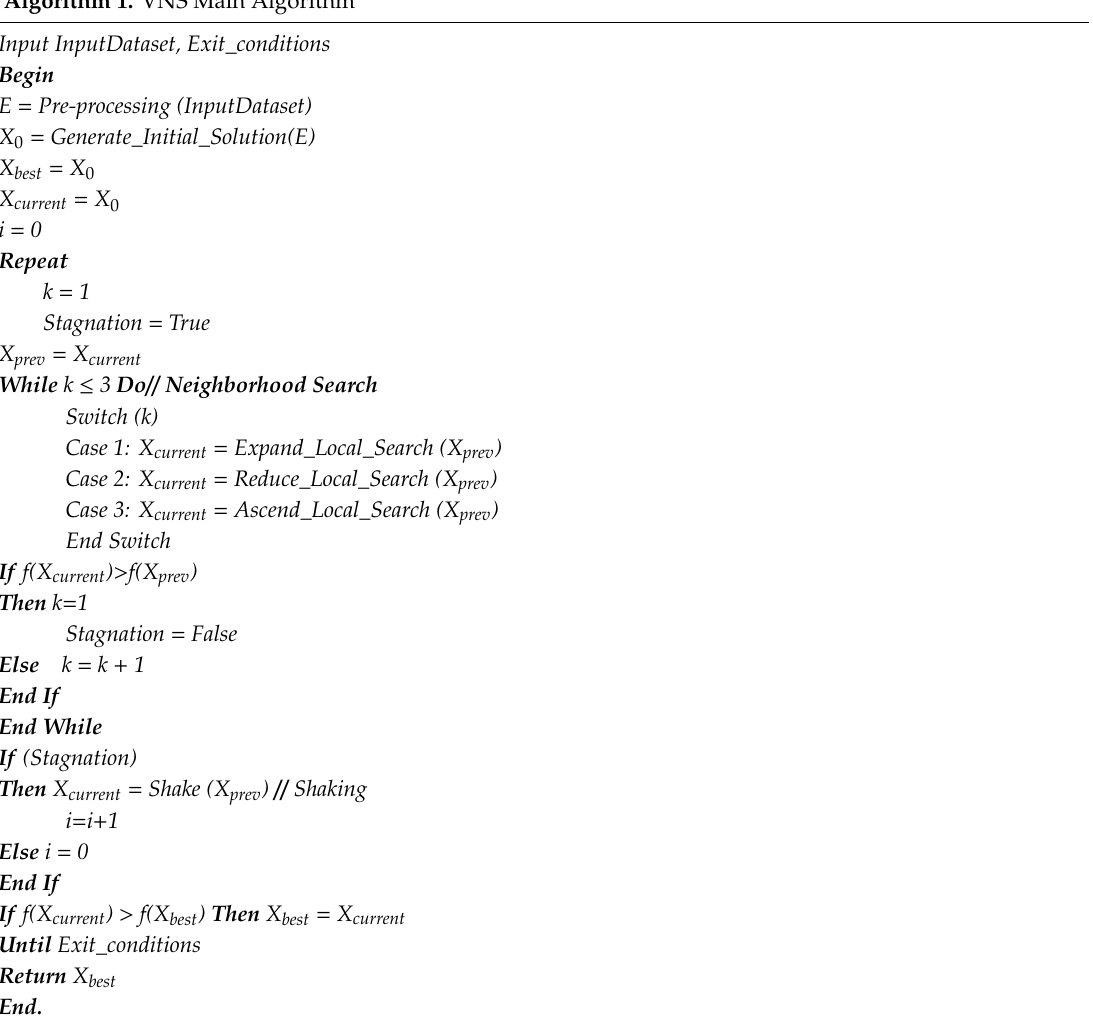
Algorithm 1. VNS Main